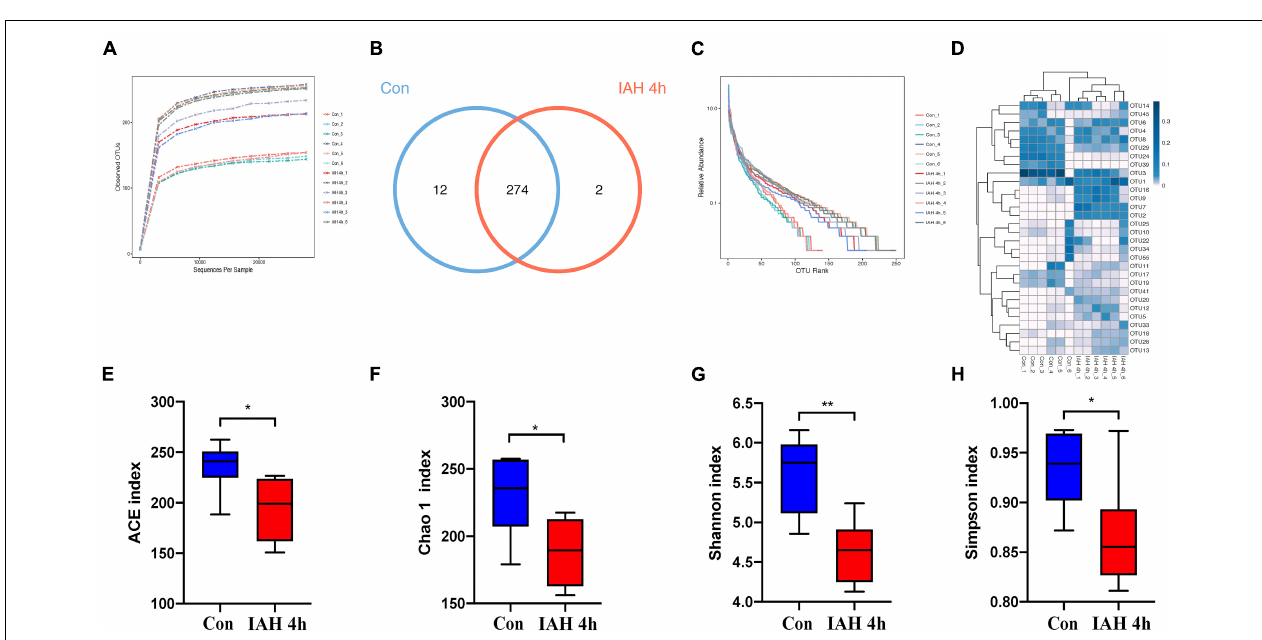
FIGURE 2 | Gut microbiota dysbiosis after IAH intervention for 4 h. Rarefaction curves (A) , bacteria OTUs (B) , OTU rank curves (C) , heatmap (D) , and composition of alpha-diversity including ACE (E) , Chao1 (F) , Shannon (G) , and Simpson (H) indices between control group with IAH 4-h group (* p < 0.05; ** p < 0.01; Con group vs. IAH 4-h group; n = 6 per